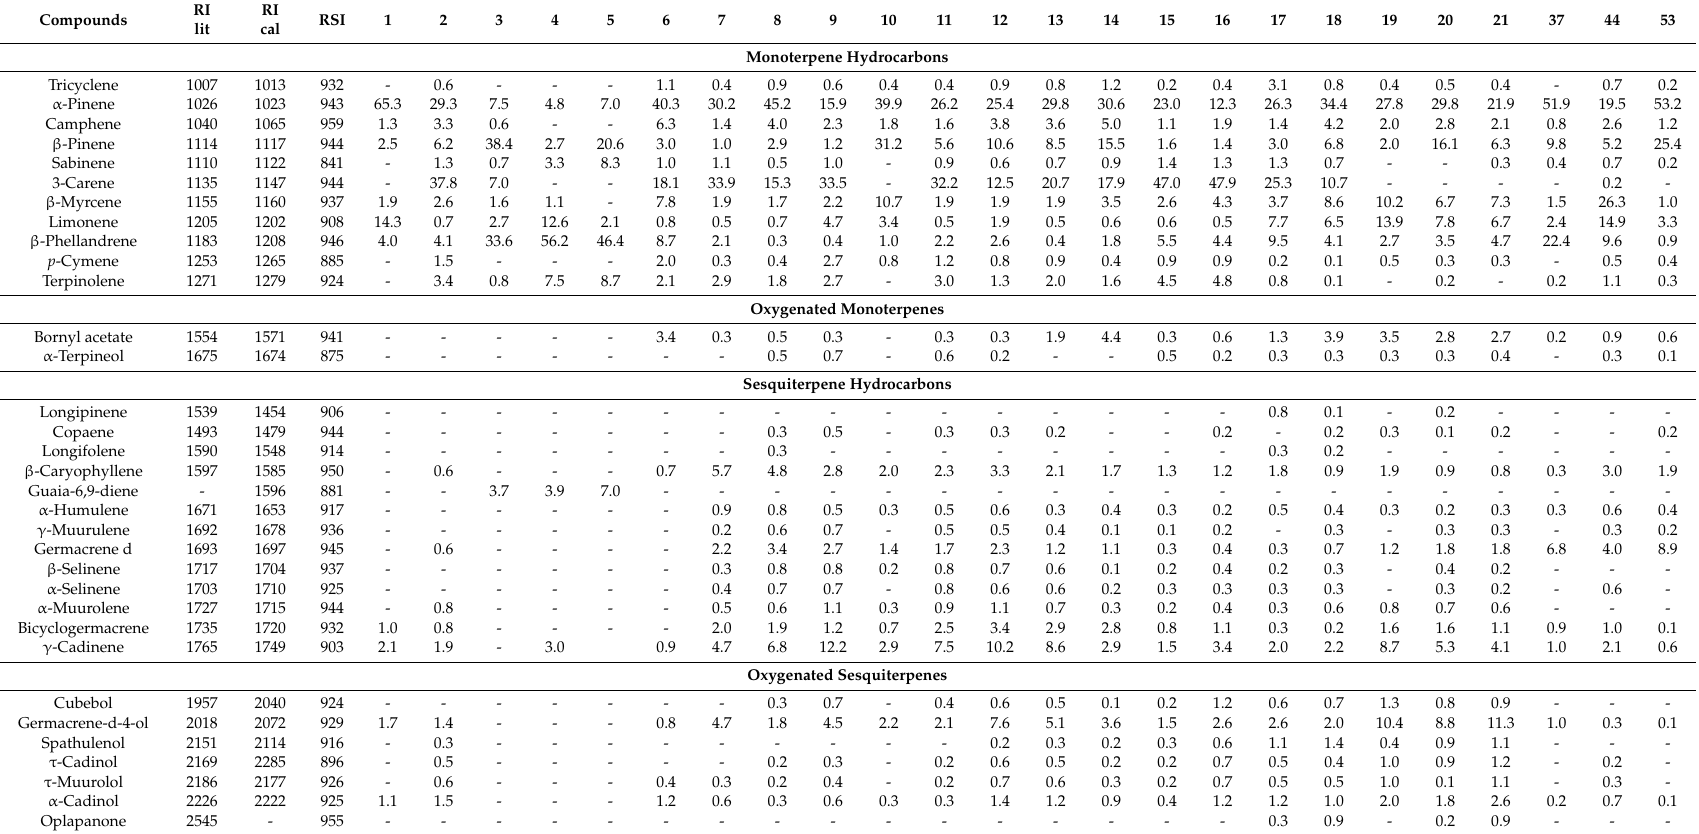
Table 1. RI values obtained from the literature (RI lit) [58] and calculated RI values (RI cal), spectral similarity index (RSI) and chemical composition (%, percentages of the total EO composition), of selected EOs ( n = 24) of pine EOs. Further data are displayed in Supplementary Tables S1 and S2. Compounds RI lit